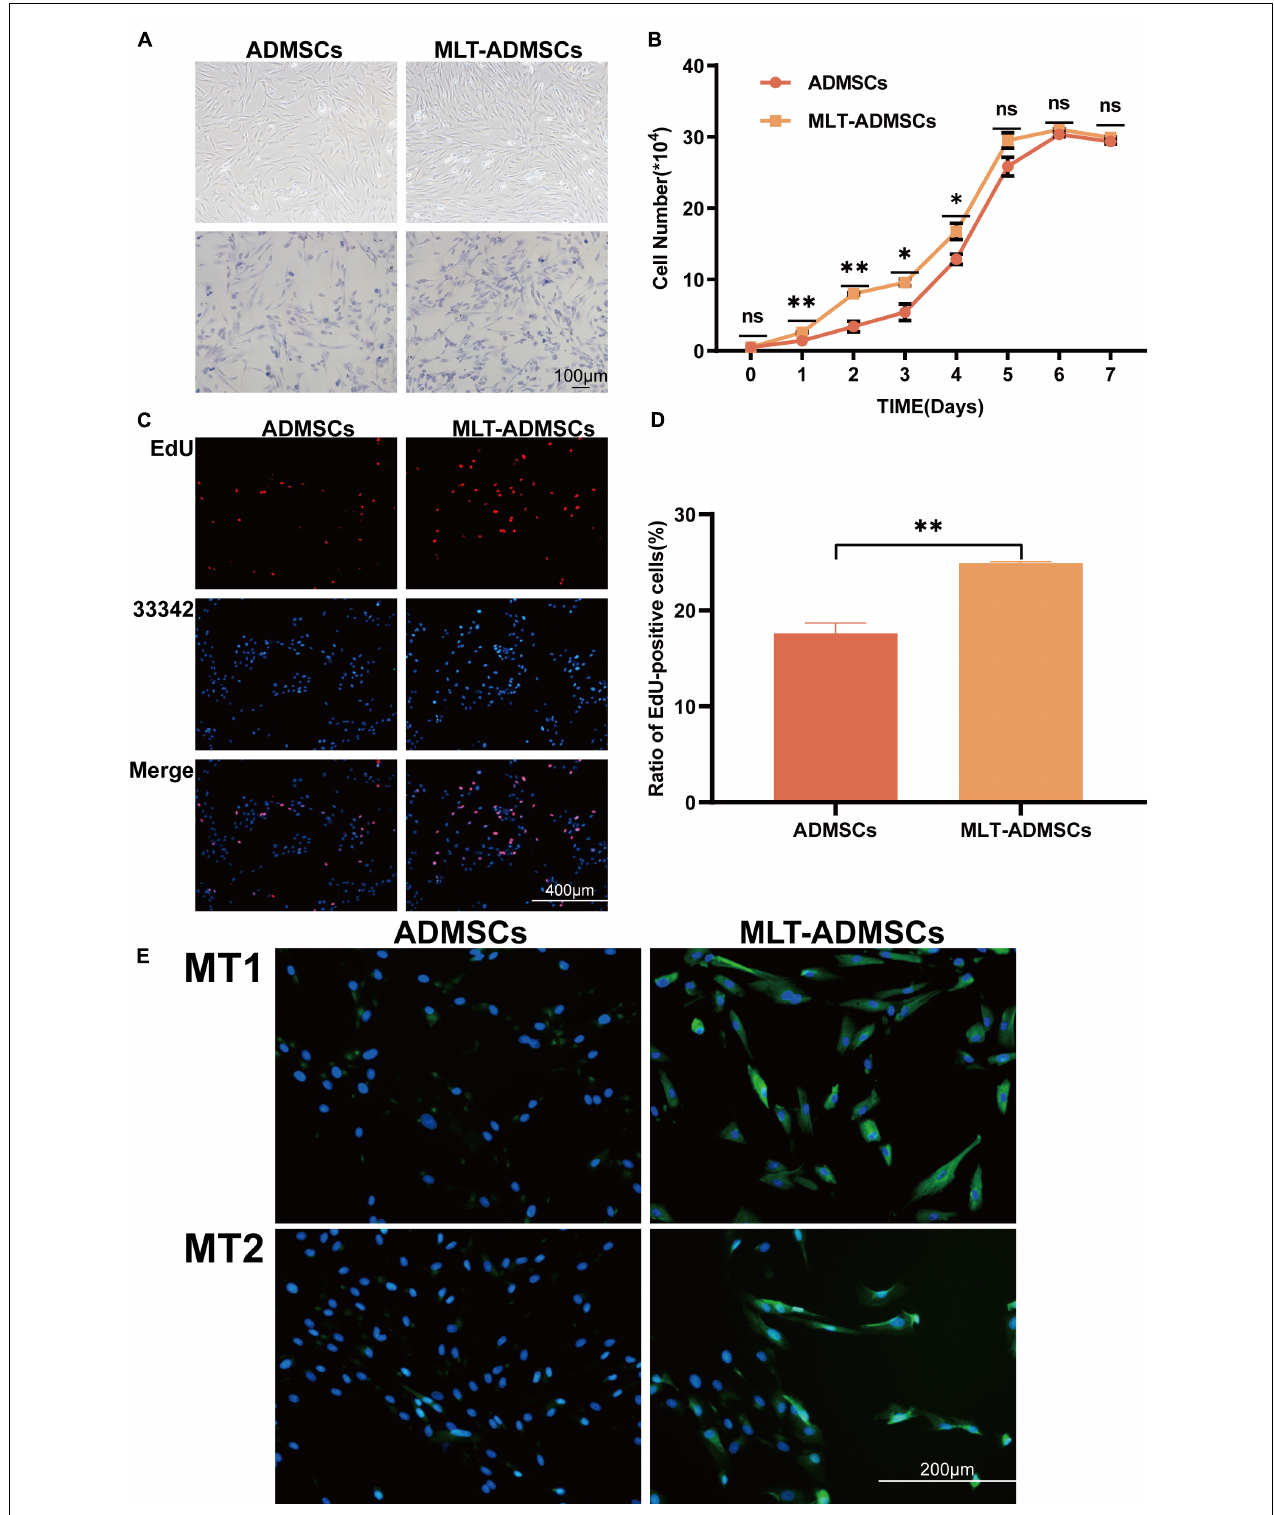
FIGURE 1 | MLT treatment can enhance the viability of ADMSCs cultured in vitro . (A) Cell morphology (ADMSCs and MT-ADMSCs). (B) Cell growth curve. (C) EdU staining. (D) Quantitative analysis of EdU. (E) MT1/MT2 immunofluorescence staining. Values in this figure are the mean ± SE; n = 3 per group; ns > 0.05, ∗ p < 0.05, ∗∗ p < 0.01 determined by a repeated-measures ANOVA.